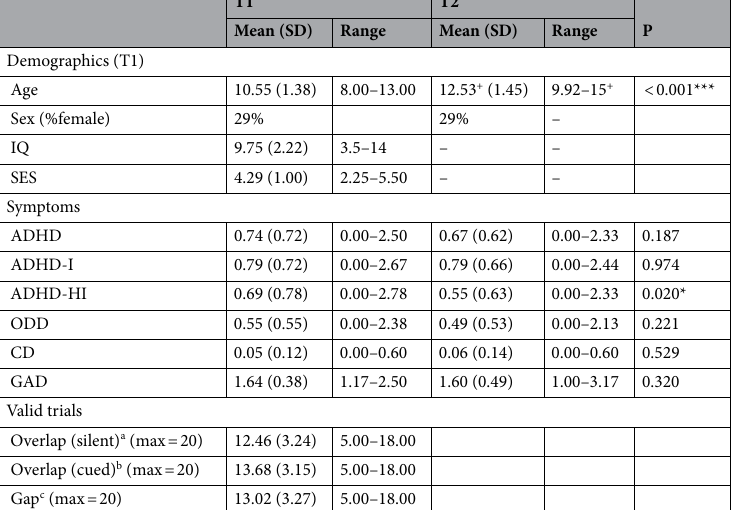
Table 1. Demographic information, symptom ratings and number of valid trials. ADHD attention-deficit/ hyperactivity disorder, ADHD-I ADHD inattentive symptoms, ADHD-HI ADHD hyperactive/impulsive symptoms, ODD oppositional defiant disorder (measure of externalizing symptoms in the analyses), CD conduct disorder, GAD generalized anxiety disorder (measure of internalizing symptoms in the